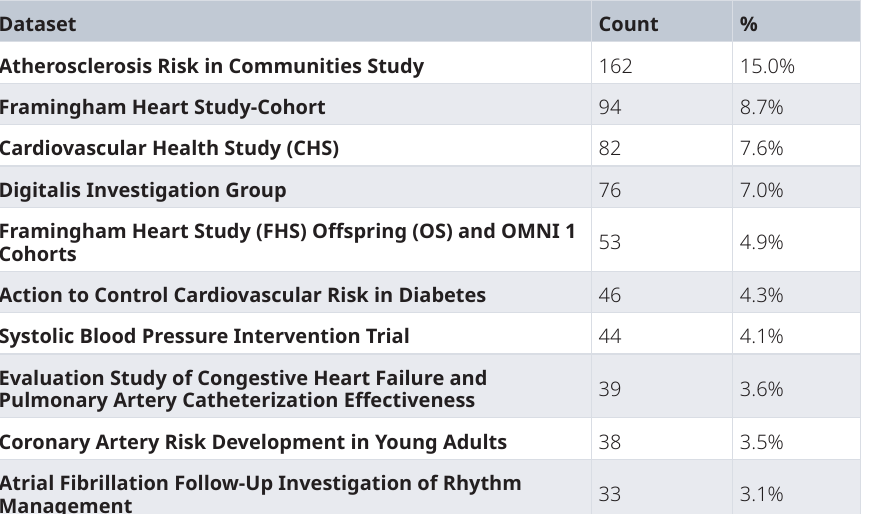
Table 1. Top 10 datasets in the Biologic Specimen and Data Repository Information Coordinating Center (BioLINCC) with highest number of publications. Dataset Count %